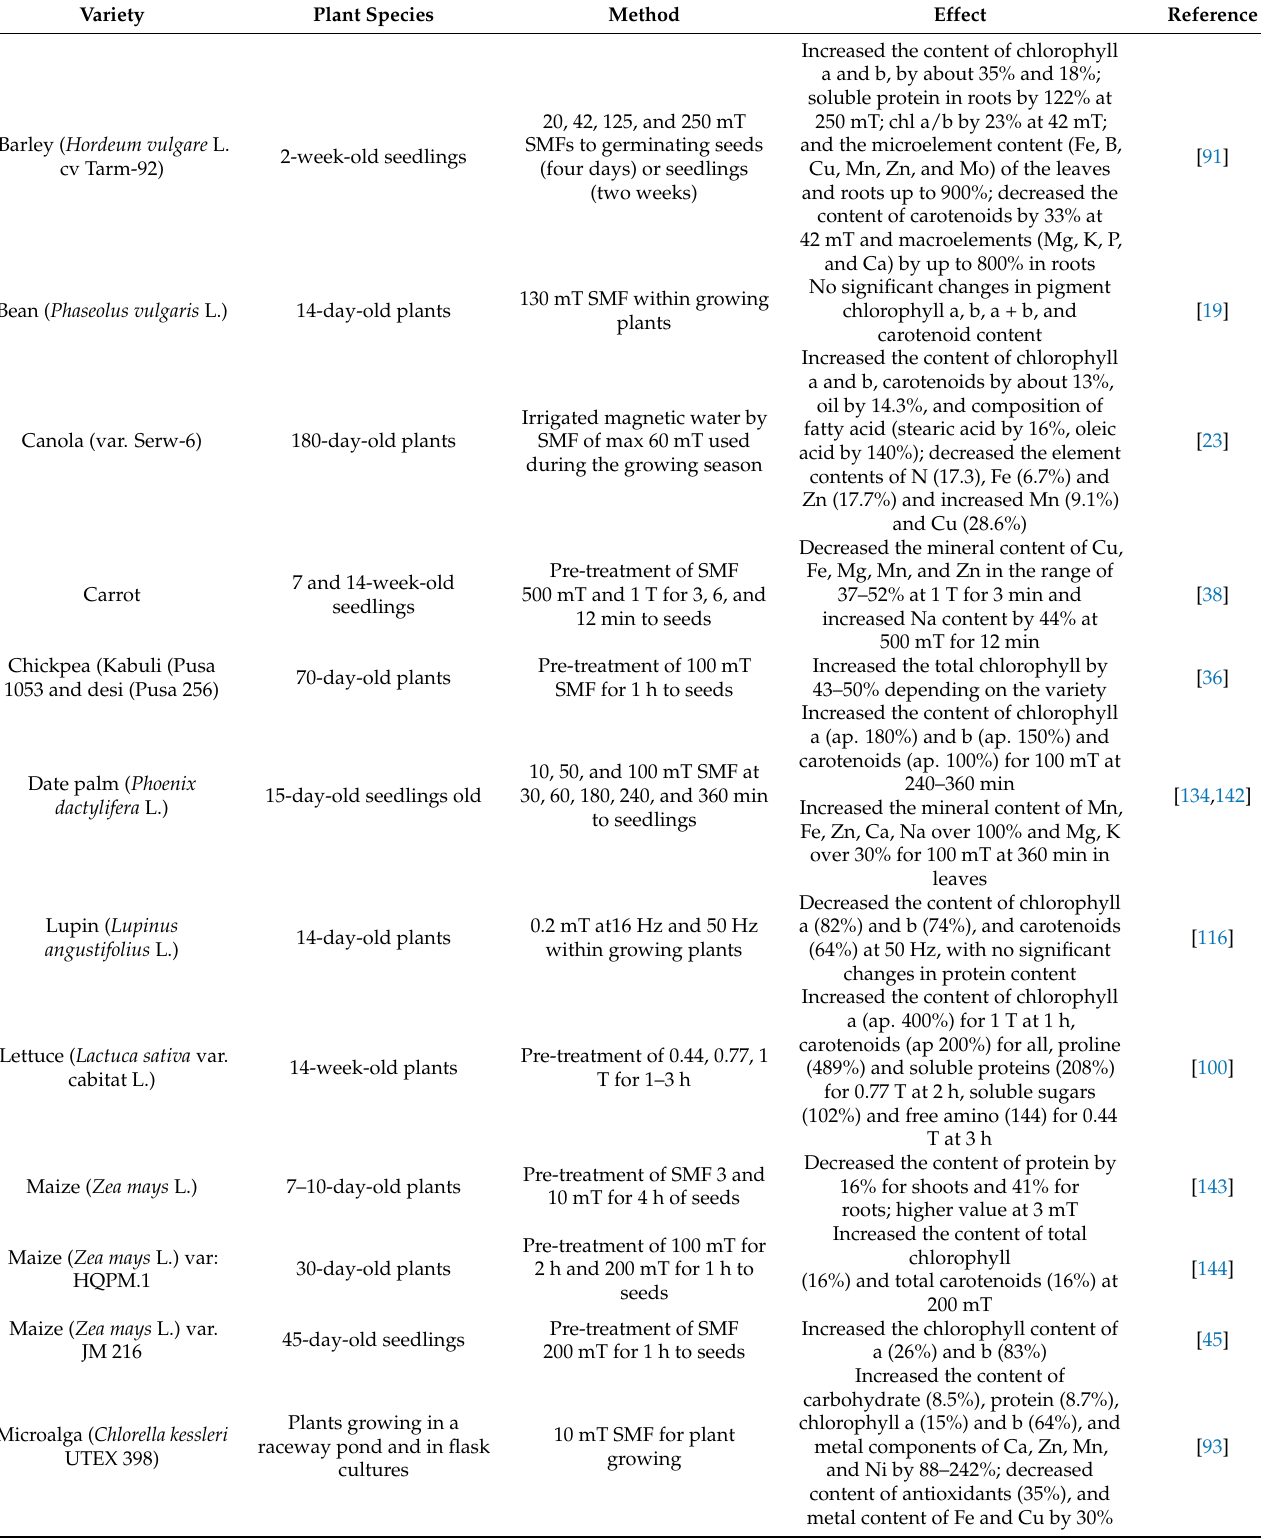
Table 4. Effects of MFs on plant